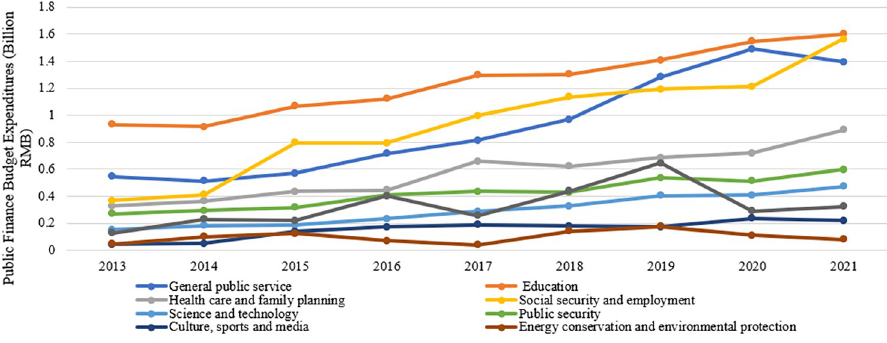
Fig 9. Comparison of the nine livelihood expenditure items in Fenghua District (County),